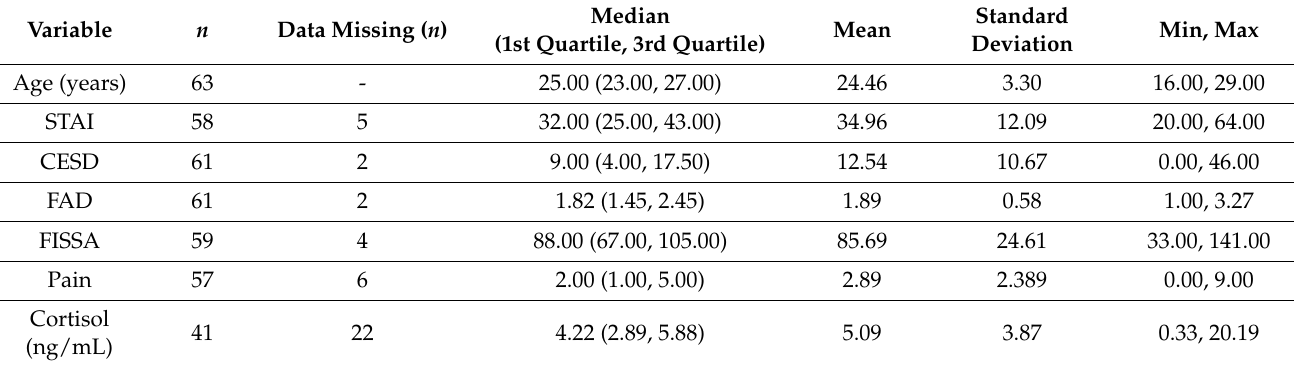
Table 3. Descriptive characteristics of baseline